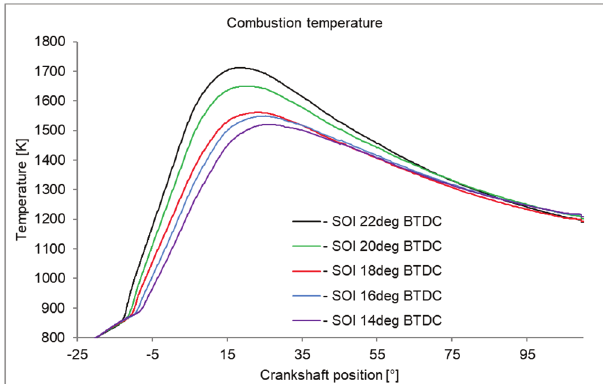
Fig. 6. Temperature of the combustion process